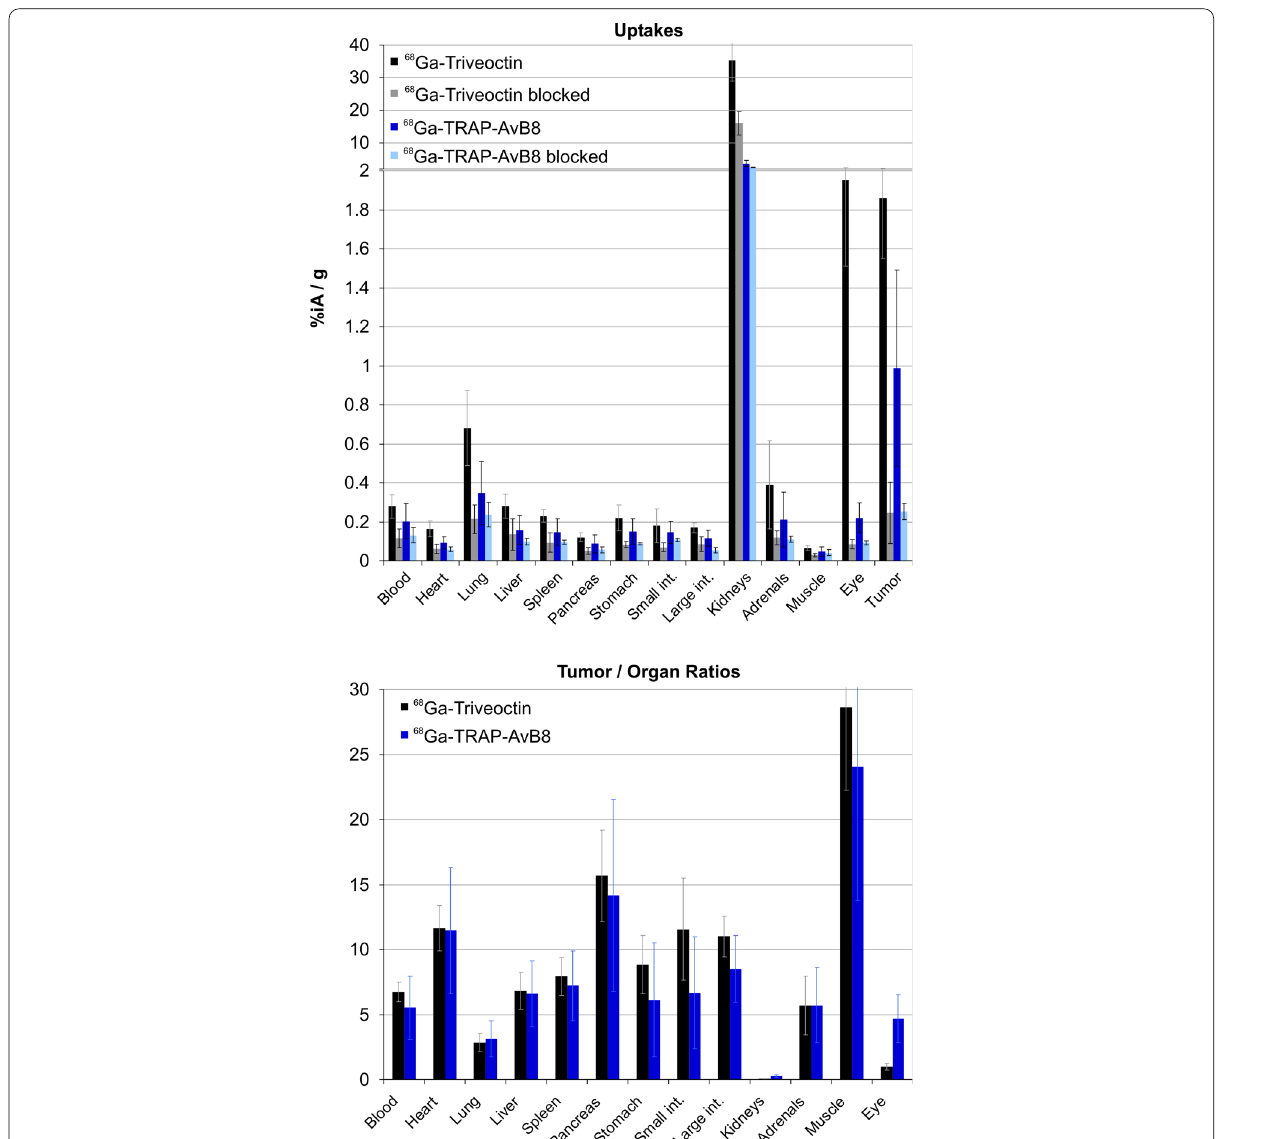
Fig. 3 Biodistribution of 68 Ga-Triveoctin, 60 min p.i. (43 13 pmol, n 6; blockade with 60 nmol Triveoctin injected 5 min prior to the ± = radiopharmaceutical, n 4) in MeWo-xenografted SCID mice, uptakes expressed as % injected dose per gram tissue; mean = 68 Ga-TRAP-AvB8 (control: 77 24 pmol, n 11; blockade: n 3) were taken from the literature [18] and are shown for comparison. Data in numerical ± = = form are given in the Additional file 1: Table